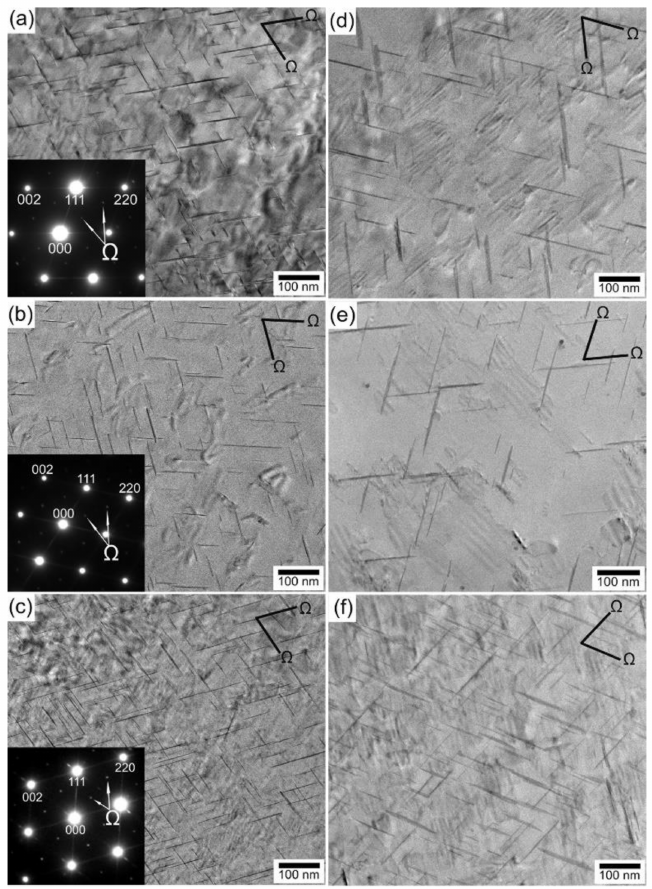
Figure 2. Bright-field TEM images and corresponding selected-area electron diffraction patterns of three Al–Cu–Mg–Ag alloys. All images are taken with the electron beam closed to the <110> α zone axis. Before the creep test: ( a ) 5.30 wt % Cu alloy, ( b ) 5.65 wt % Cu alloy, and ( c ) 6.00 wt % Cu alloy. After the creep test at 200 ◦ C under 250 MPa: ( d ) 5.30 wt % Cu alloy, ( e ) 5.65 wt % Cu alloy, and ( f ) 6.00 wt % Cu alloy.